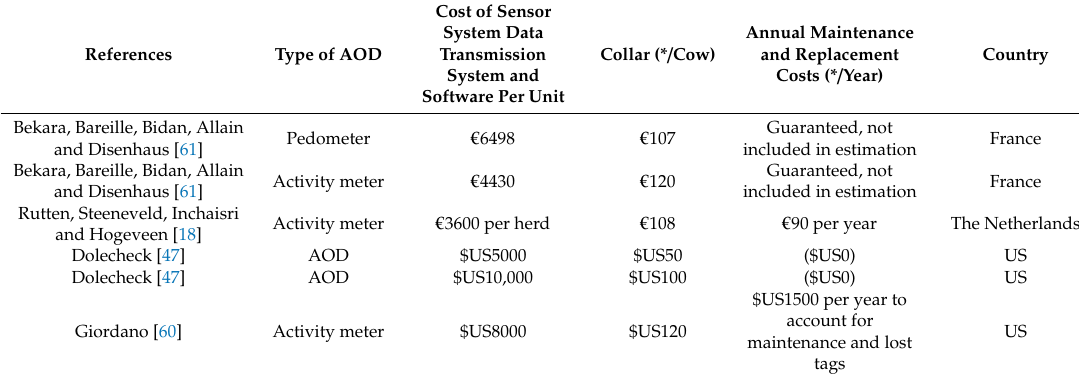
Table 3. Cost of investment in AOD